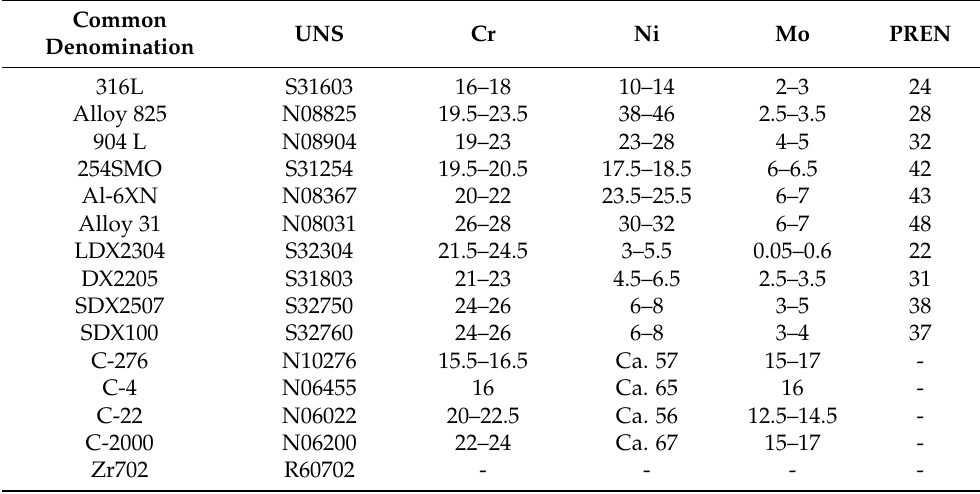
Table 1. Chemical composition and PREN values of all tested